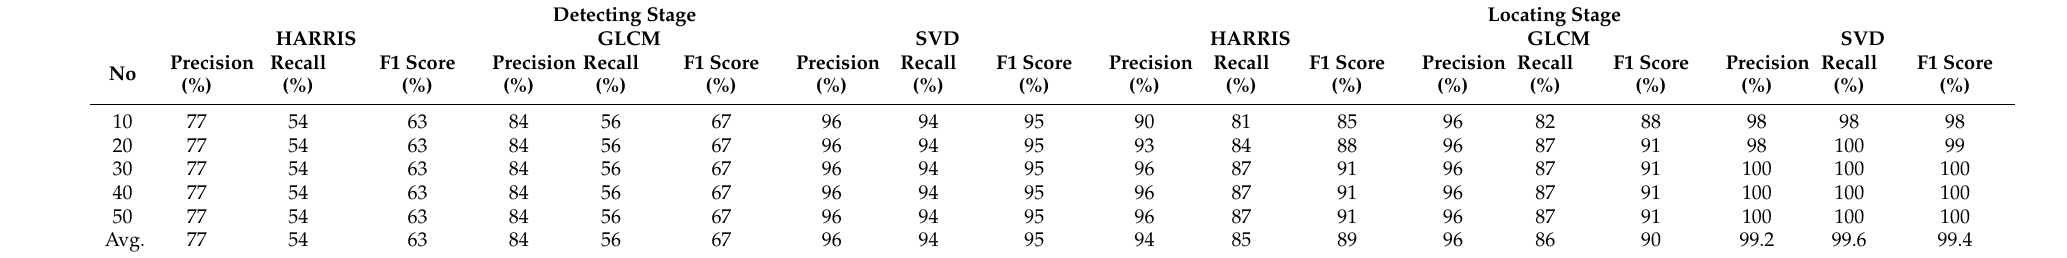
Table 5. Insertion detecting and locating performance measures of the proposed scheme for three different feature extraction